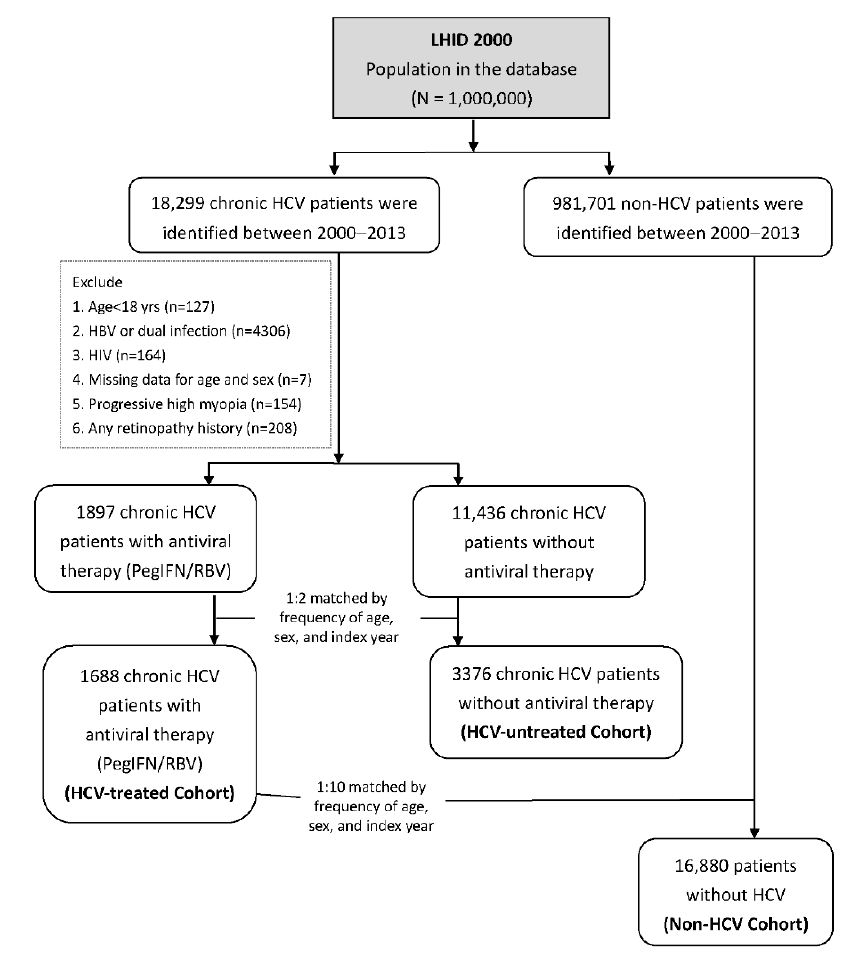
Figure 1. Flow chart of patient enrolment.